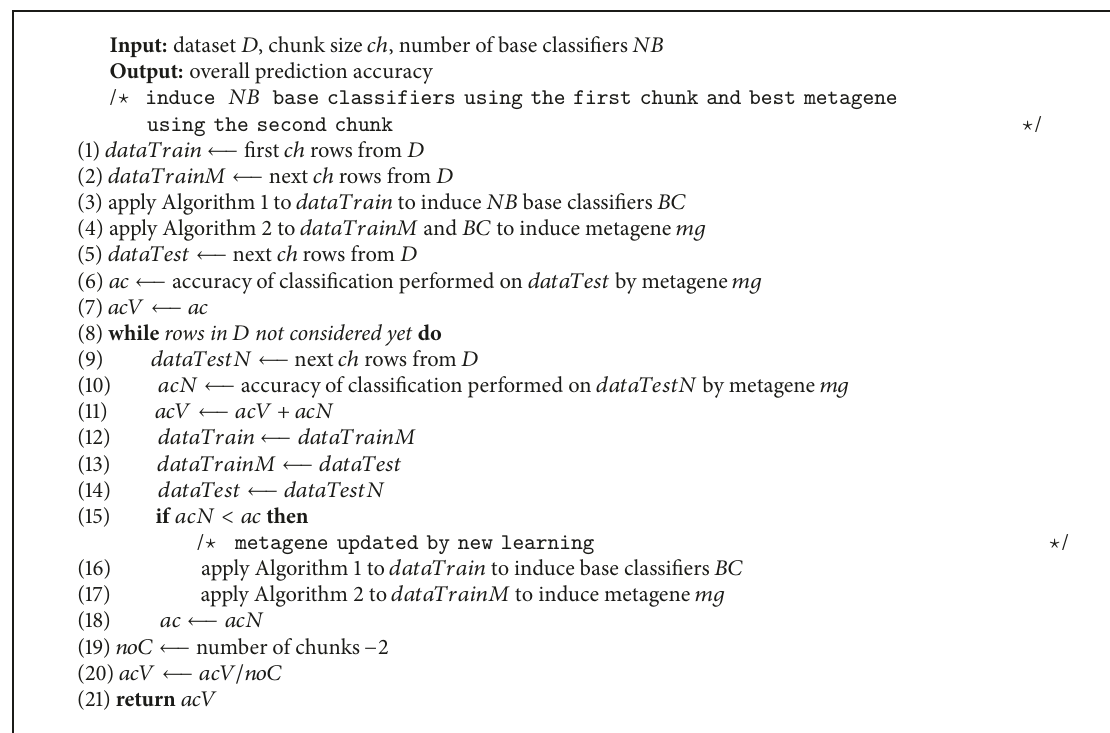
Algorithm 3: Incremental classifier with data reduction and ADAPT1 adaptation mechanism.